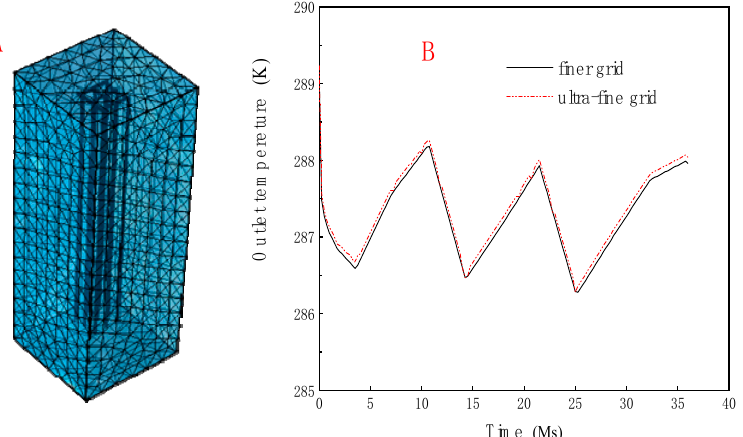
Figure 8. Illustration of the model meshing. ( A ) chart of meshing way; ( B ) comparison chart of the fine grid and ultra-fine grid.